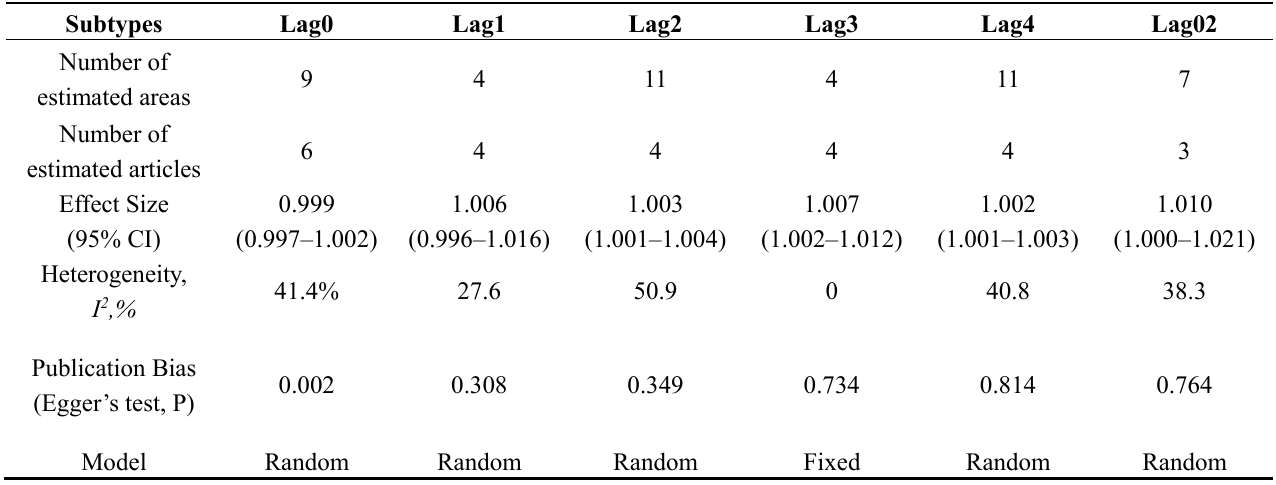
Table 5. Sensitivity Analyses for Cold Effects: Lag